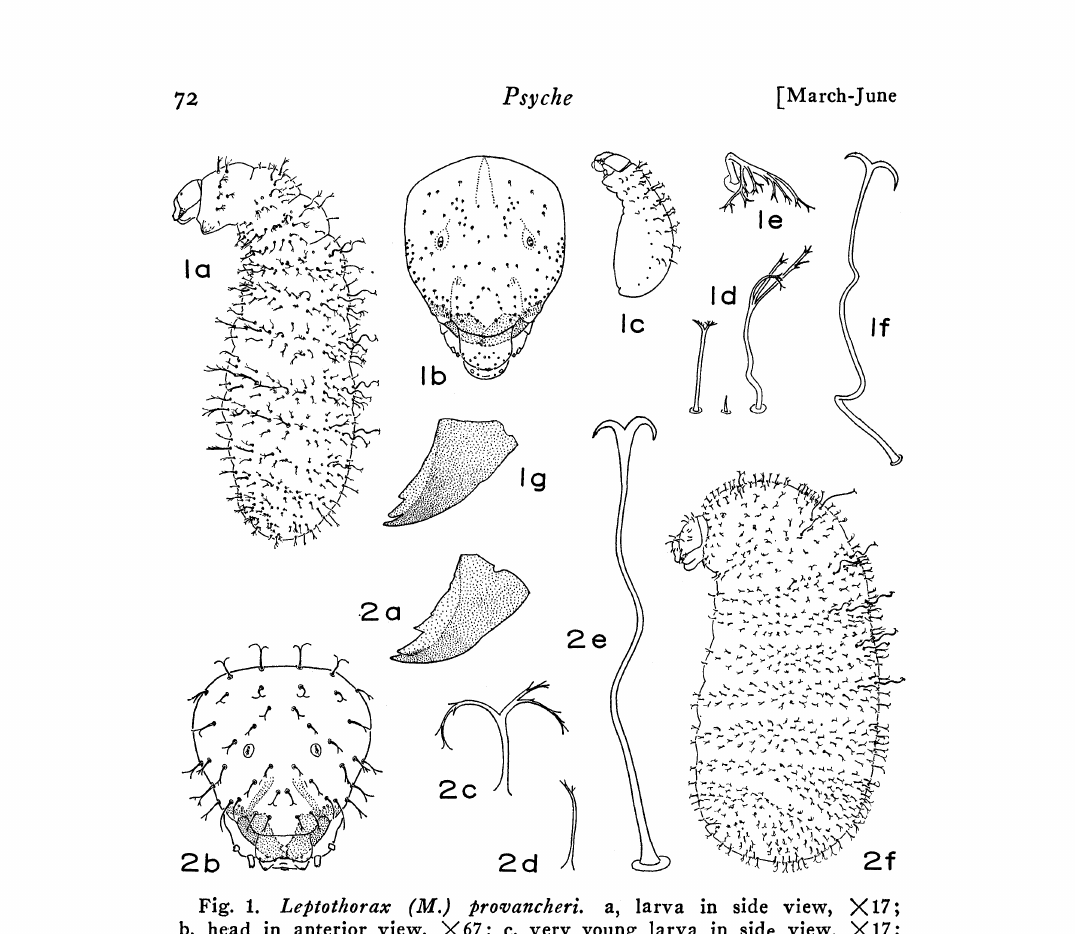
Fig. 1. Le#tothorax (M.) #rovancheri. a, larva in side view, X17; b, head in anterior view, X67; c, very young larva in side view, X17; d, simple and branched body hairs, X169; e, surface view of dendritically branched body hair, X169; f, anchor-tipped body hair, X169; g, left mandible in anterior view, X163. Fig. 2. Rogeria #rocera. a, ieft mandible in anterior view, X169; b, head in anterior view, X 67; c and d, branched body hairs, X264; e, anchor-tipped body hair, X264; f, larva in side view X